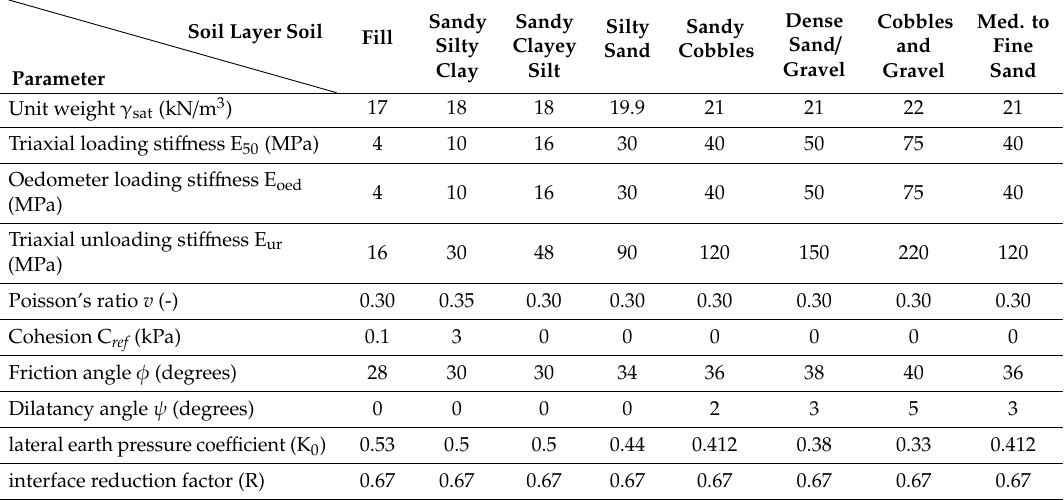
Table 1. Properties of soil layers and